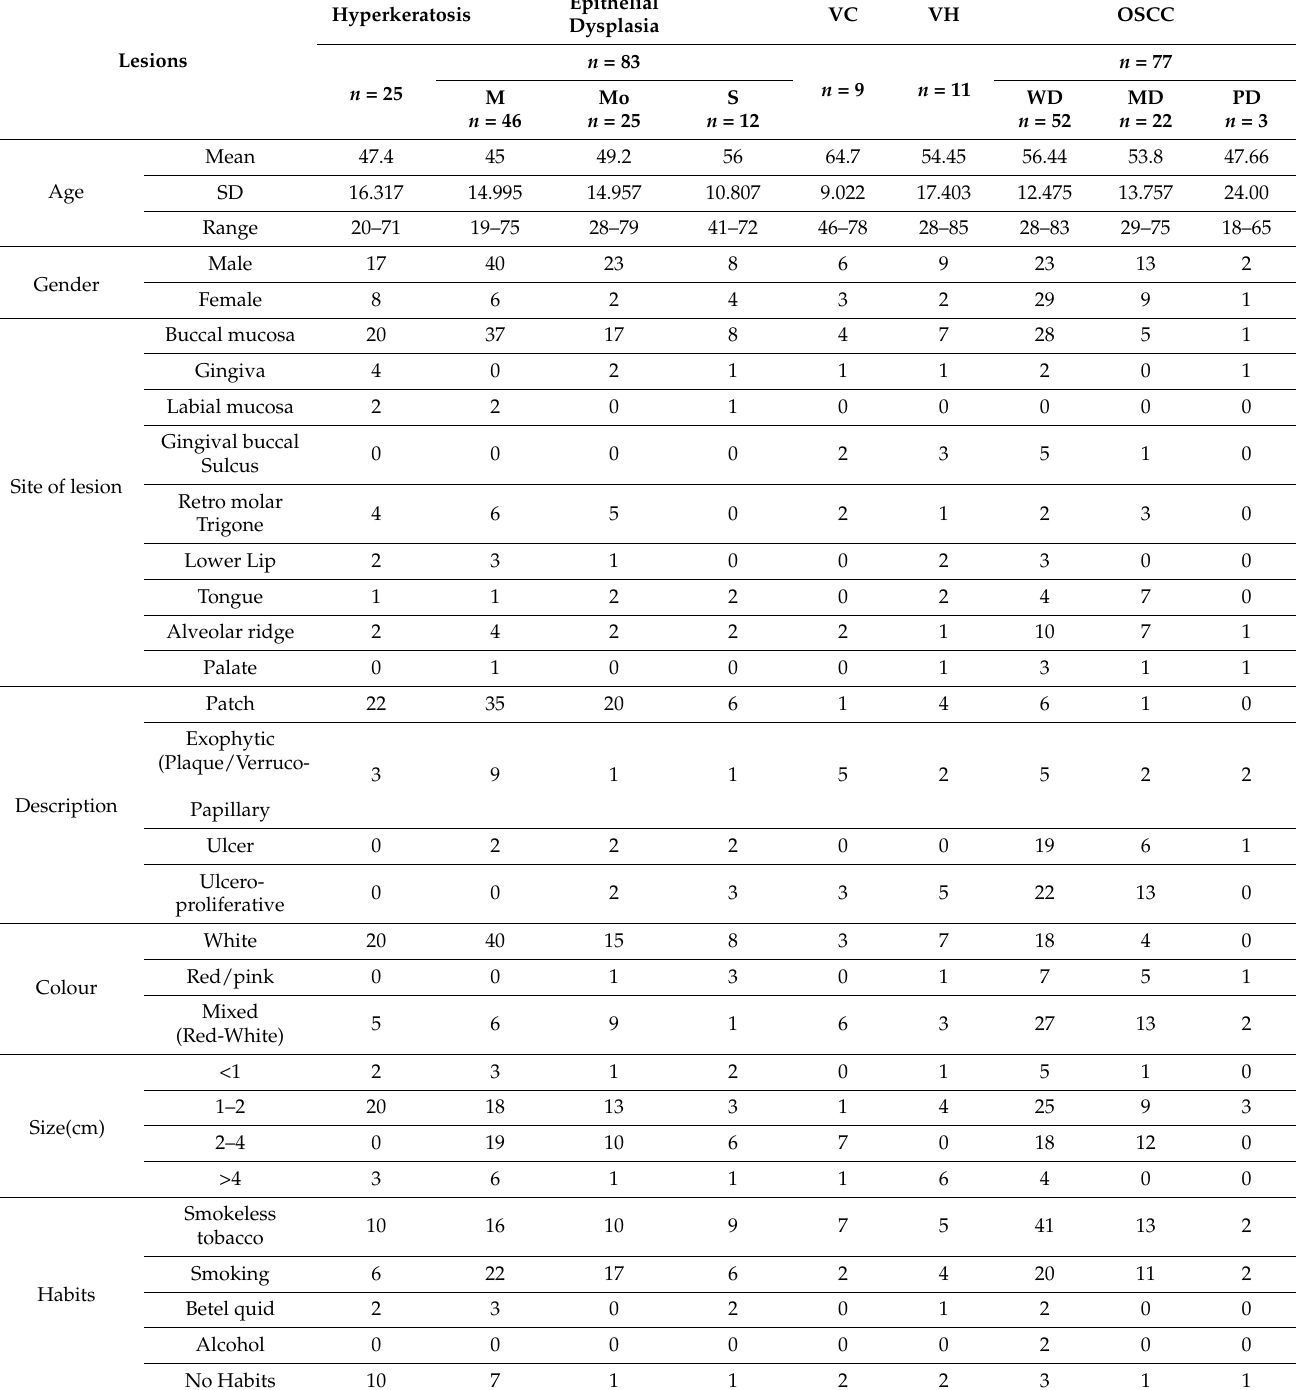
Table 3. Demographic and clinical characteristics of the